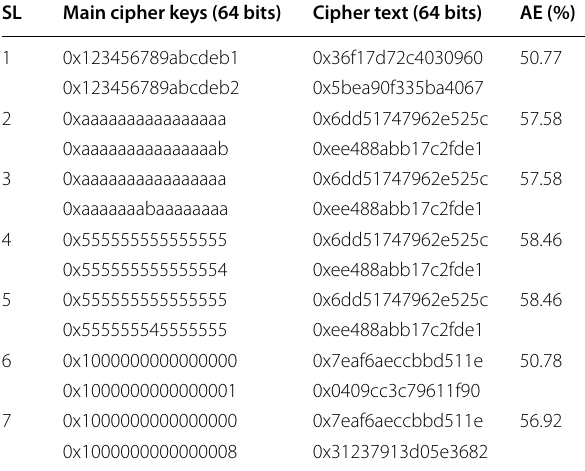
Table 2 Avalanche effect (AE) of key generation technique